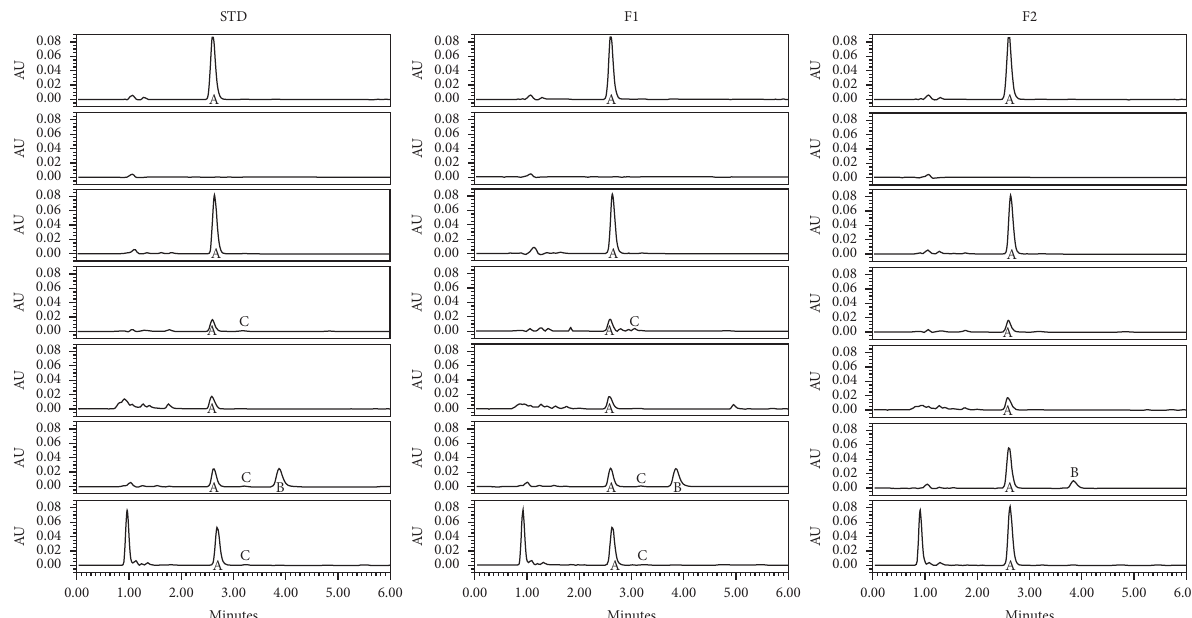
Figure 3: Specificity test of the method. Chromatograms of samples of t-RSV STD, F1, and F2 are observed without stress (I), their placebos (II), and under conditions of forced degradation for 24h at a temperature of 60 ° C (III), acid hydrolysis (IV), basic hydrolysis (V), UV light (VI), and oxidation (VII). The peak “A” is trans -resveratrol, peak “B” is its isomer, and cis -resveratrol and peak C are believed to be